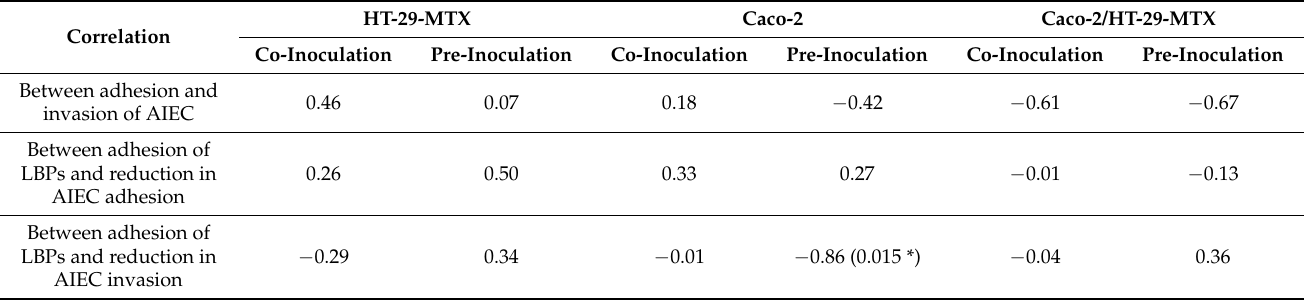
Table 3. The correlation between adhesion and invasion of AIEC in HT-29-MTX, Caco-2 and co-culture cells, as well as the correlation between LBP adhesion on the cell lines and reduced adhesion and invasion of AIEC. * Shows significant correlation. p -values that are only significant have been